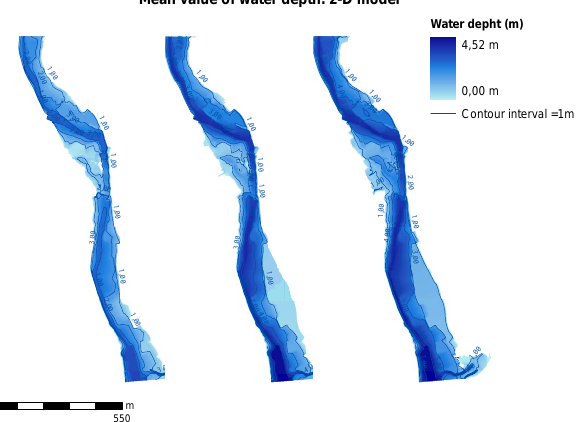
Fig. 16. 2-D SWE model. Flood maps with mean values of velocity predicted by point-estimate method for flow cases of 200m 3 s − 1 (left panel), 300m 3 s − 1 (middle panel) and 500m 3 s − 1 (right panel).